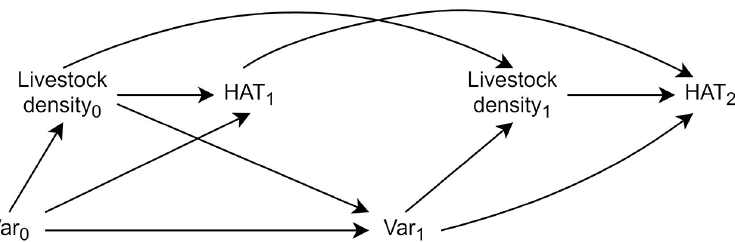
Fig 2. Time-varying directed acyclic graph (DAG) demonstrating exposure-confounder feedback. HAT 1 and HAT 2 refer to HAT risk at two time points. Var 0 is a vector containing wealth, NDVI, and LST at the first of two hypothetical time points, and Var 1 is a vector containing the same variables at the second time point. Var 1 is a confounder of the livestock density 1 —HAT 2 pathway, but is a mediator of the livestock density 0 —HAT 1 and livestock density 0 —HAT 2 pathways, thus adjustment of Var={Var 0 , Var 1 } will bias the joint (over time) effect of livestock density on